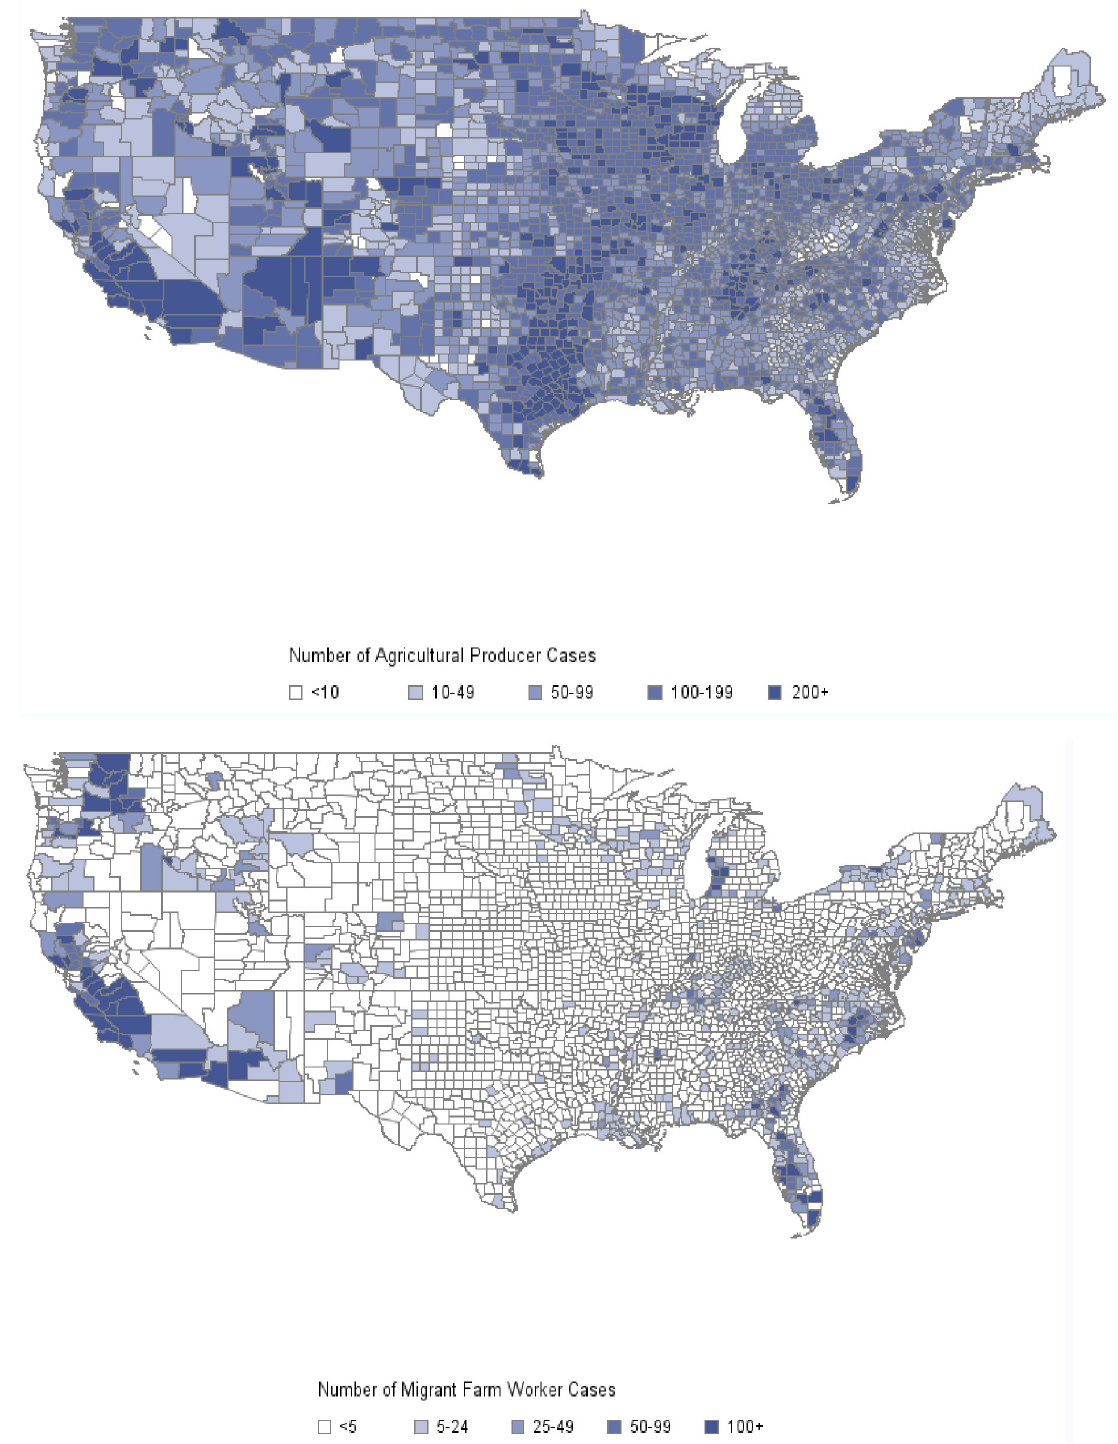
Fig 3. Spatial distribution of cumulative number of estimated cases among agricultural producers and migrant workers by March 31, 2021.